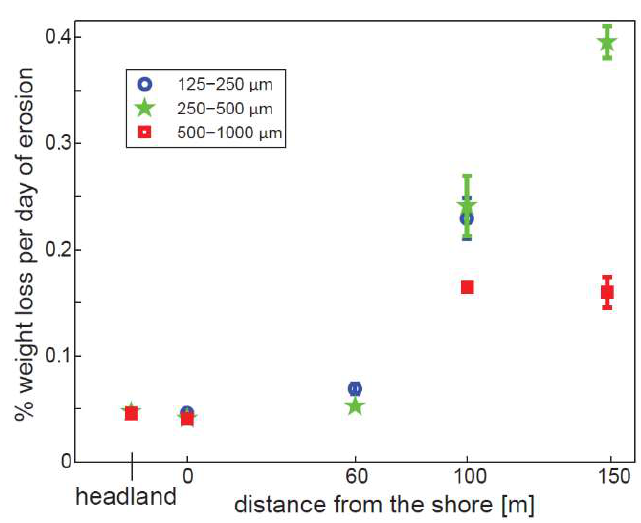
Figure 6. Grain erosion experiments. Mass abraded from samples taken at different locations along the transect and at the headland (point #4 in Figure 1c). Each sample was abraded for 24 h in triplicates; error bars indicate ± one standard deviation.